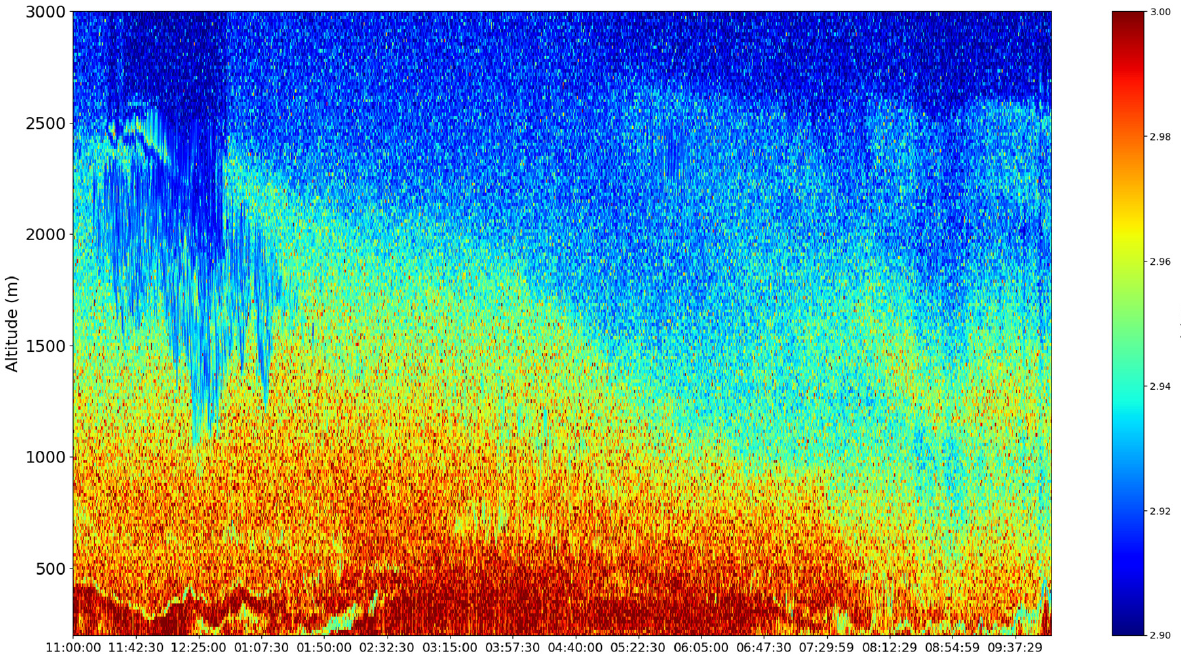
Figure 20. Zoomed-in D (cid:2890) timeseries, λ = 1064 nm , Gala ț i, Romania, 22 December 2021.